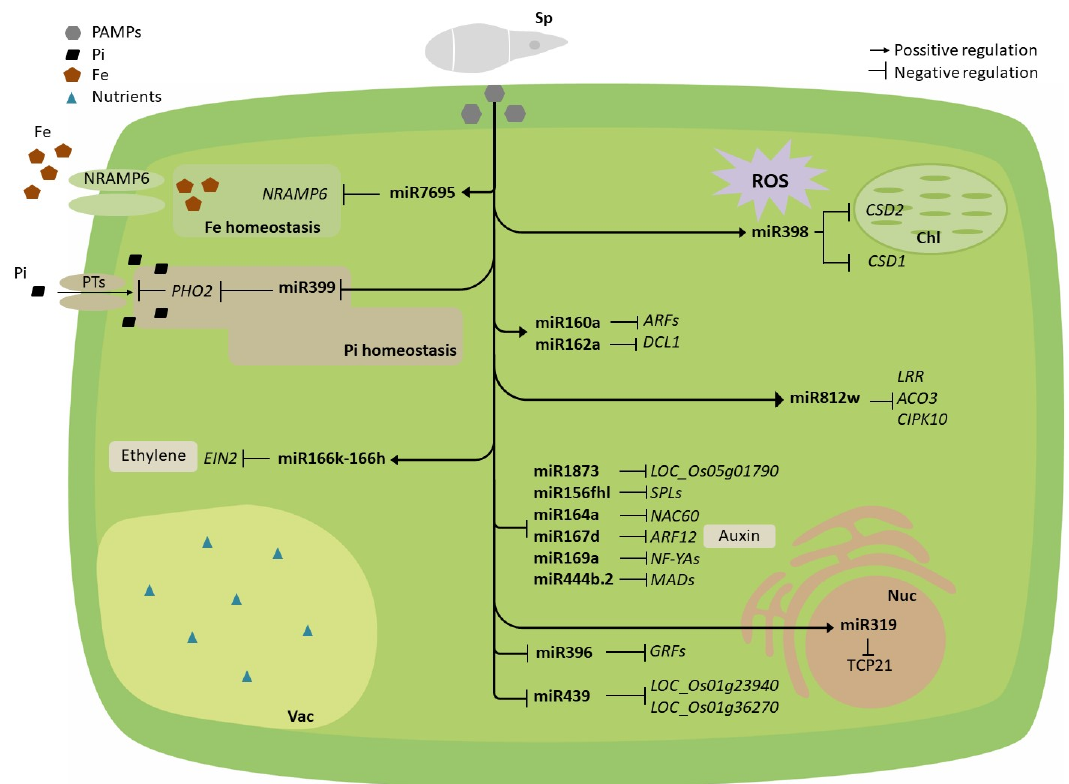
Figure 2. miRNAs with a known function in the response of rice plants to infection by the blast fungus M. oryzae. The miRNA/target gene modules and the biological processes that they regulate are indicated. ACO, 1-aminocyclopropane-1-carboxylase oxidase3; ARF12, Auxin response factor; Chl, Chloroplast; CIPK, Calcineurin B-Like (CBL)-interacting serine– threonine protein kinase; CSD, Copper superoxide dismutase; DCL1, Dicer-like protein; EIN, Ethylene-insensitive protein 2; GRF, Growth regulating factors; LRR, Leucin-rich repeat; NAC, No apical meristem; NF-YA, Nuclear transcription factor Y subunit alpha; NRAMP, Natural resistance-associated macrophage protein; Nuc, Nucleus; PHO, Phosphate; PTs, Phosphate transporters; ROS, Reactive oxygen species; SPL, SQUAMOSA promoter-binding protein-like transcription factor; Sp, Spores; TCP, Teosinte branched/cycloidea/pcf; Vac, Vacuole.